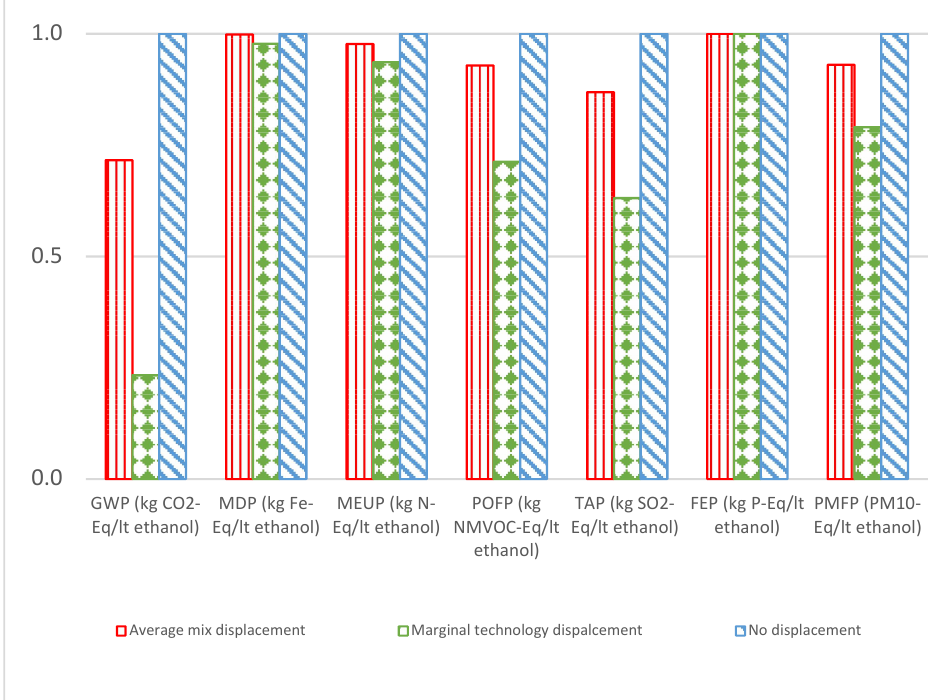
Figure 2. Comparison of life cycle environmental impacts at cradle-to-plant-gate for the three different system expansion scenarios: Average mix displacement, marginal technology displacement and no displacement. The impact results were normalized to a factor of 1 according to the impact category result indicator of the scenario “No displacement”.